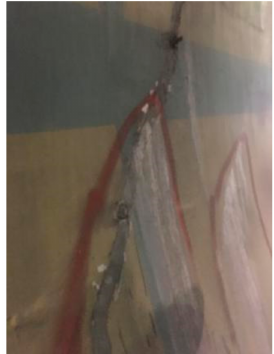
Figure 2. Cracking of the tunnel